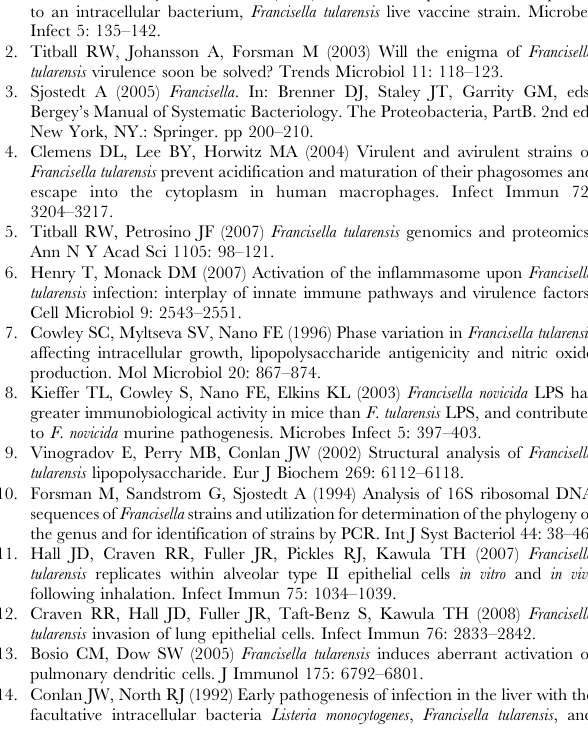
Table S1 Inhibition of F. novicida growth by various classes of antibiotics. F. novicida wildtype U112 and fopC mutant strain were grown to 0.6 OD 600 , diluted to a Mcfarland 1 standard and 100 m l of each culture was confluently spread onto Mueller-Hinton agar plates, and the antibiotic discs placed on the plates. The plates were incubated at 37 u C overnight and the zones of inhibition in mm measured around each disc. Data presented above is the average of readings from three discs of each antimicrobial.